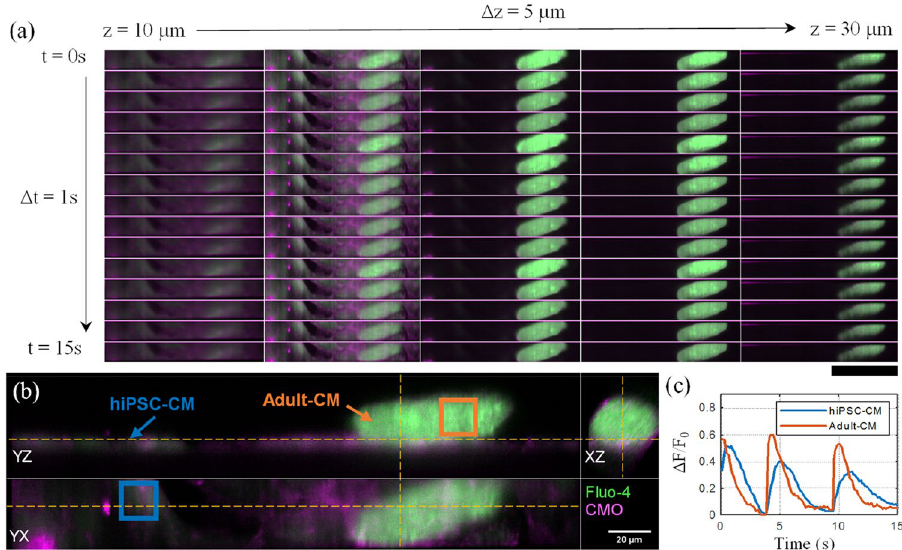
Figure 5. 3D timelapse imaging of synchronized spontaneous transients in adult-CM and hiPSC-CM co-cultured for 24 h. ( a ) Montage showing merged Fluo-4 (green) and CMO (magenta) 3D time-lapse for a single unpaced 15 s acquisition acquired at 8 vps, see Supplementary Videos 4,5. Each column represents XY-planes spaced 5 µm apart axially within the central third of the z-range (increasing upwards from coverslip) of the volume. Each row represents timepoints 1 s apart. Scalebar: 100 µm. ( b ) Orthogonal cuts through the merged channels displayed at the peak of the second transient (t = 4.6 s). Yellow lines indicated the intersecting planes of the displayed orthoslices. ( c ) Calcium transient ΔF/F 0 time traces calculated over the three- dimensional 100 × 100 × 1-pixel ROI within hiPSC-CM and adult-CM cells, indicated by the blue and orange rectangles respectively in ( b